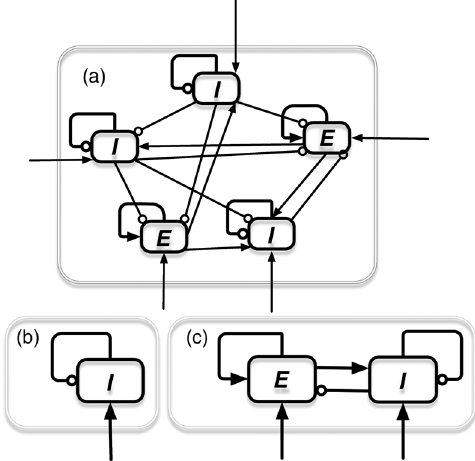
FIG. 1. Network schematics . Arrows (circles) denote excitatory (inhibitory) connections. (a) The general network architecture studied here consists of multiple excitatory ( E ) and inhibitory ( I ) subpopulations driven by external inputs. Individual connections are randomly diluted or are Gaussian distributed. Subpopulations are distinguishable by the different statistics of connectivity. (b) The simplest model consists of a single population with random inhibitory recurrent connections with an external excita- tory input. (c) Two randomly connected E and I